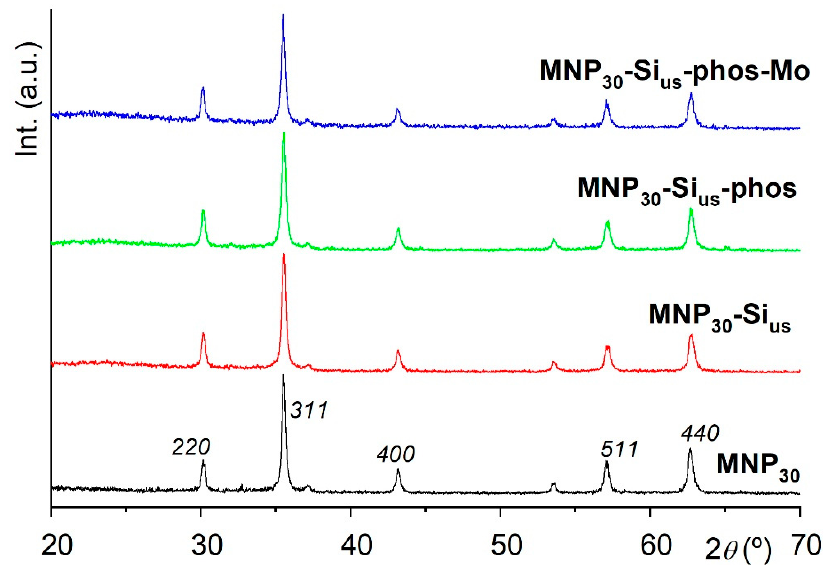
Figure 1. Powder XRD patterns of all materials prepared through the ultrasonication path starting from MNP 30 (bottom) are shown. Labels show the most relevant magnetite (Fe 3 O 4 ) plans.